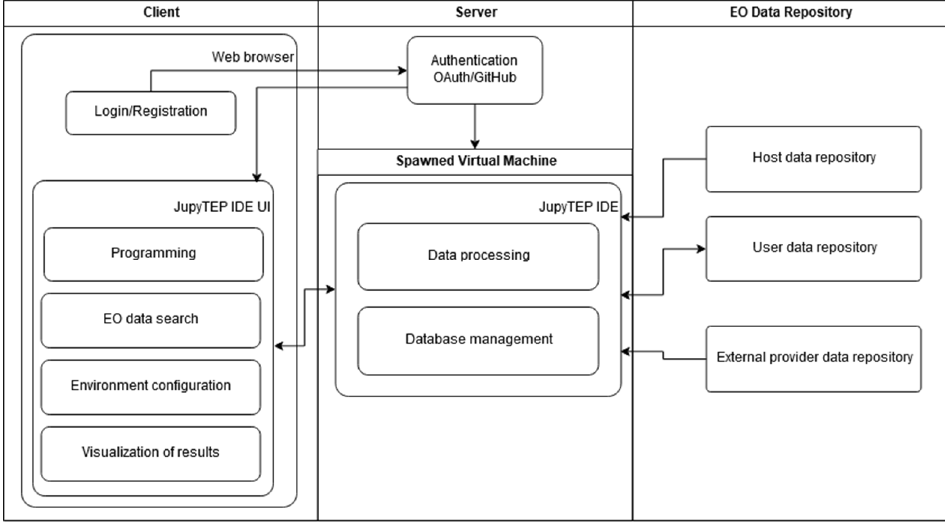
Figure 5. Functional scheme of system architecture.